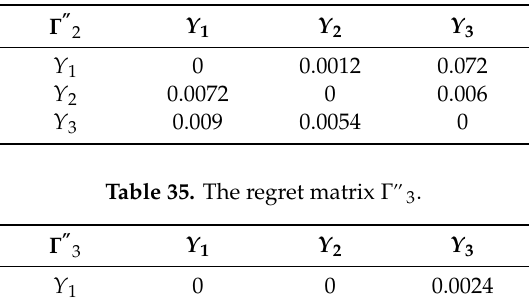
Table 34. The regret matrix Γ (cid:48)(cid:48) 2 .